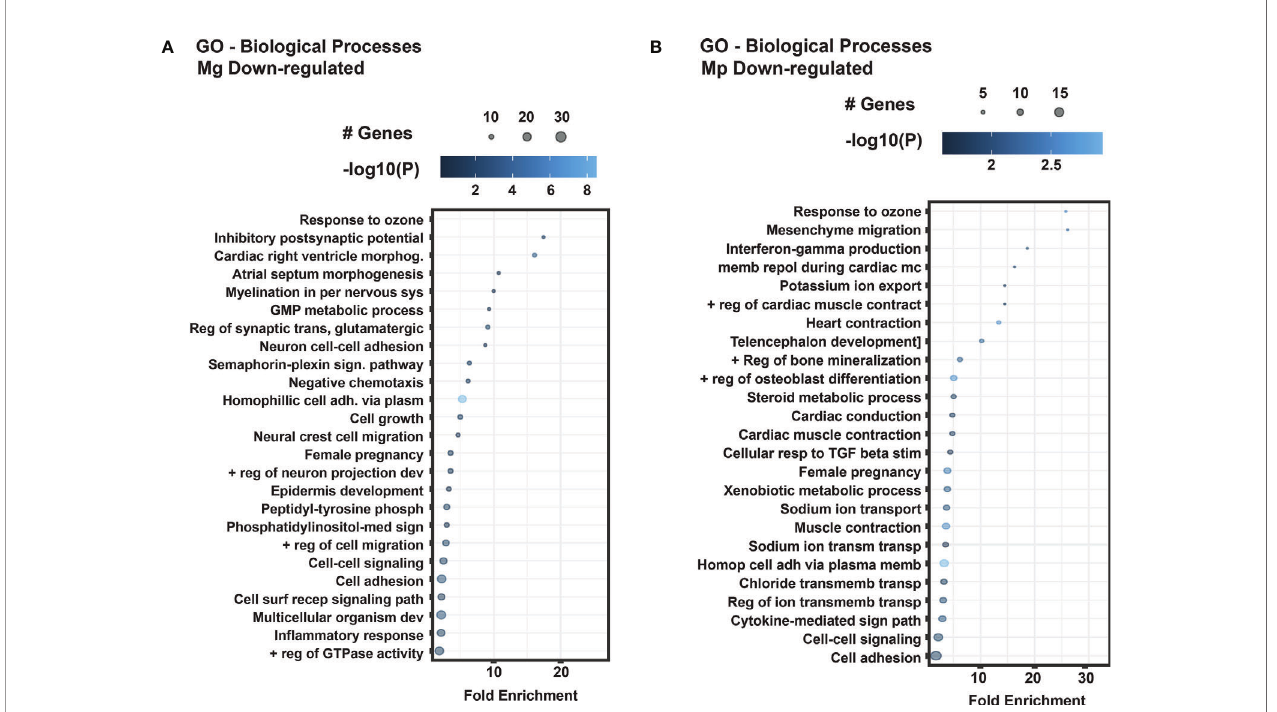
FIGURE 5 | GO Biological processes of differentially expressed down-regulated genes in M. genitalium (Mg) and M. pneumoniae (Mp). (A) Dot blot for the enriched biological process of differentially expressed down-regulated genes in Mg. (B) Dot blot for the enriched biological process of differentially expressed down-regulated genes in Mp. Dot blots measure fold enrichment of the pathways, and dot size represents total number of genes included in each category, and gradient color shows statistical signi fi cance [-log 10 ( P